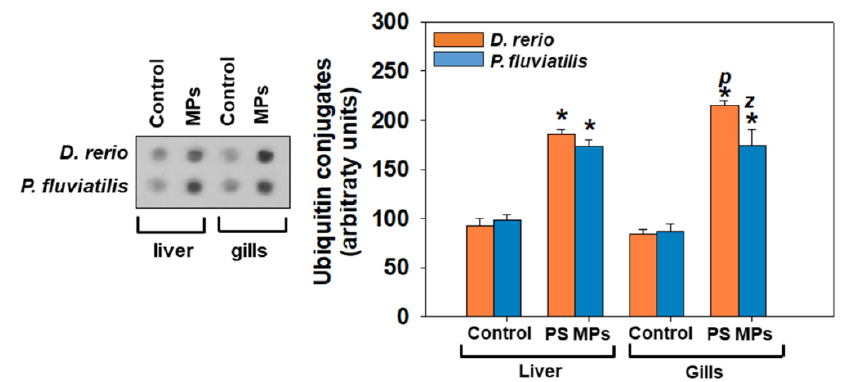
Figure 5. Ubiquitin conjugates (mean ± SD) in liver and gills of Danio rerio ( n = 3 pools of 10 individuals) and Perca fluviatilis ( n = 6). Mann–Whitney U test was employed to test for significance at p < 0.05 between all experimental groups. * denotes significant differences ( p < 0.05) compared to the control group ( n = 3 pools of 10 individuals and n = 6 for D. rerio and P. fluviatilis respectively), while z and p denote significant differences ( p < 0.05) between D. rerio and P. fluviatilis respectively.